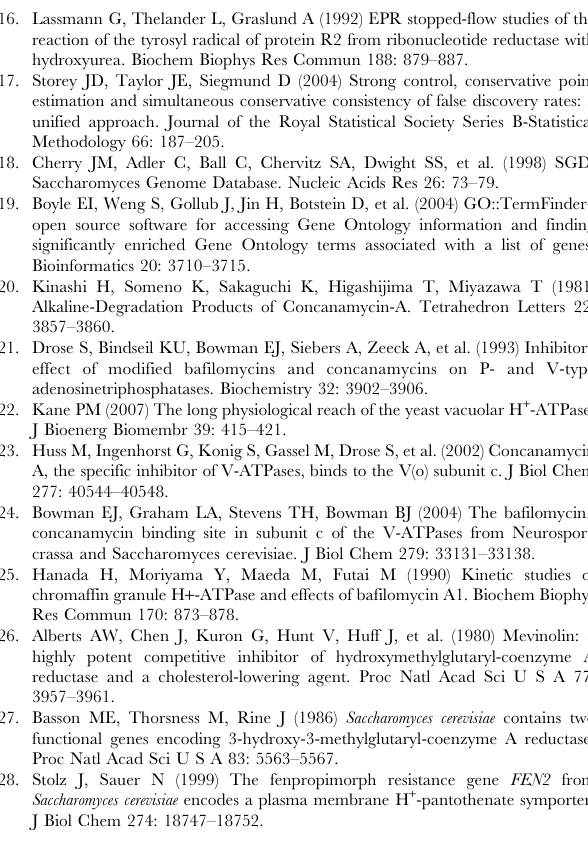
Table S5 A list of parameters identified from lovastatin-treated cells using Jonckheere-Terpstra tests at FDR = 0.20. The color scheme is the same as Table S1. A) A list of parameters detected at stage A (unbudded cells with one nucleus). B) A list of parameters detected at stage A1B (budded cells with one nucleus). C) A list of parameters detected at stage C (budded cells with two nuclei). D) A list of parameters that represent various cell ratios. Table S6 A list of GO terms enriched in the top 100 genes ranked by the high-content image-based profiling for lovastatin treatment. Of the 4718 genes, 4379 genes were associated to at least one GO term, in which 92 of top 100 genes ranked by high- content image-profiling for lovastatin were included. Using the GO term finder (see Materials and Methods), significant enrichment of three GO terms was detected at P , 0.05 with the Bonferroni correction (Corrected P-value column) among the 92 genes from 4379 genes, and GO terms associated with 100 and fewer genes in the 4379 genes (Number of annotations in the 4718 genes column) were listed.